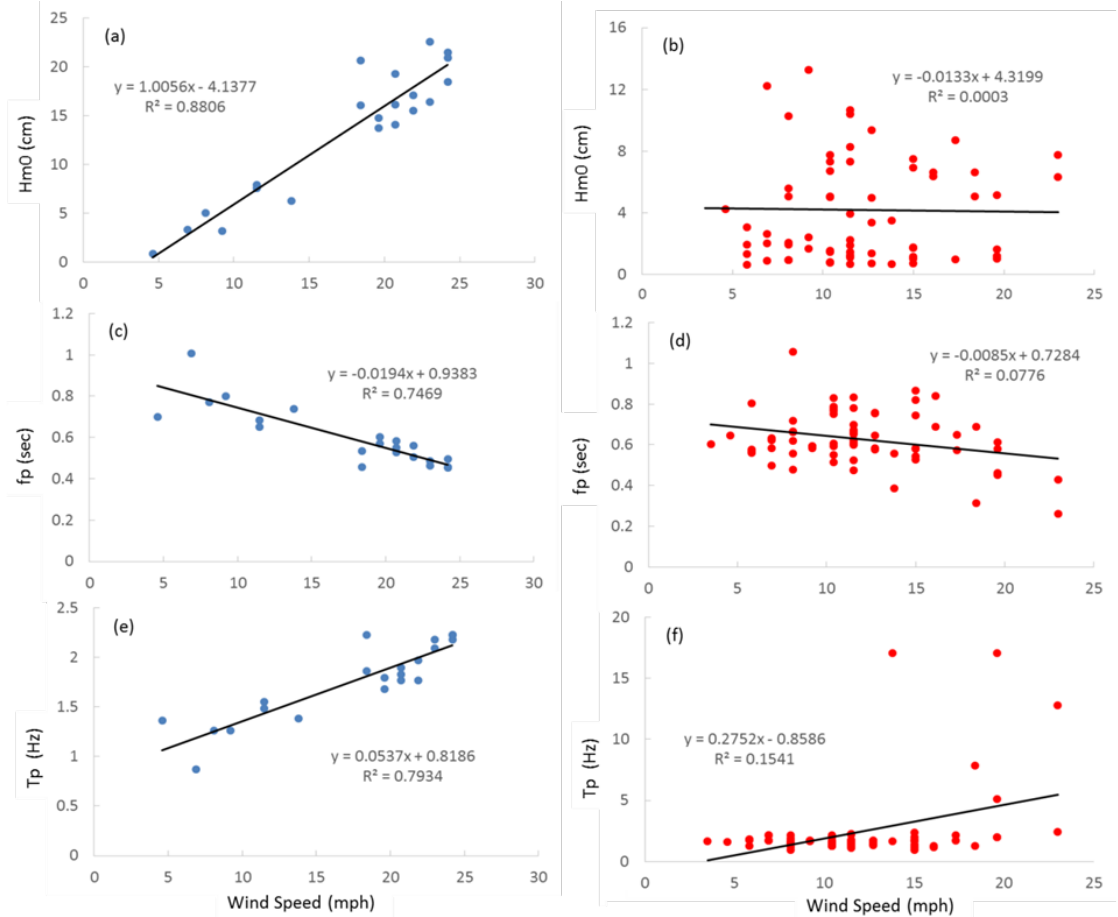
Figure 3. Wind directional group (WDG) 1 (left column in blue) and WDG 3 (right column in red) regression analysis for wind speed (independent) versus dependent variables ( a ) and ( b ) significant wave height (Hm0); ( c ) and ( d ) wave period (fp); and ( e ) and ( f ) wave frequency (Tp). Note that the y axis units are different on each graph.